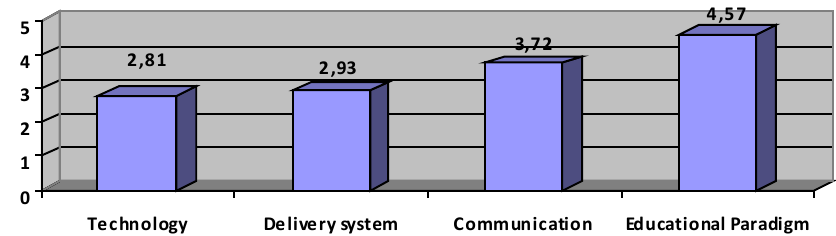
Figure 1. Evaluation of the four definition categories by the participating experts (1 = does not represent the e-learning concept ; 5 = represents the e-learning concept exactly